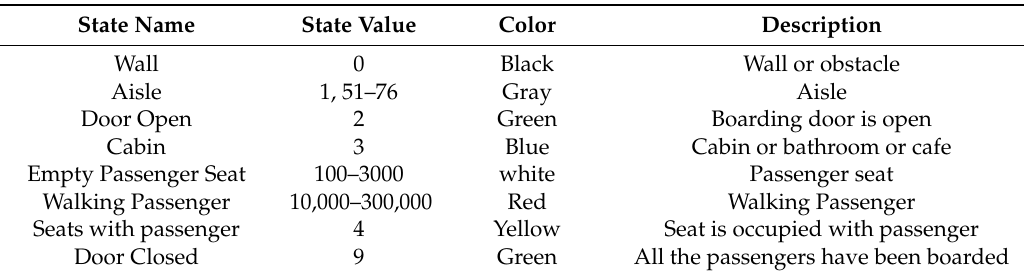
Table 3. Cellular state values.